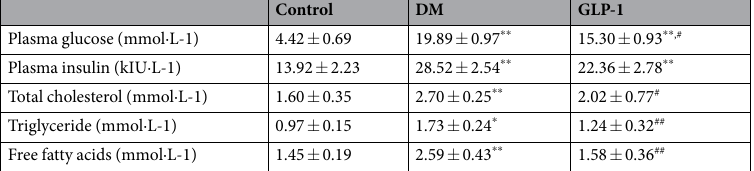
Table 1. Plasma glucose, Plasma insulin, Total cholesterol, triglyceride, and Free fatty acids. Data are shown as the mean ± SEM, n = 8 independent experiments. * P < 0.05 vs control, ** P < 0.01 vs control. # P < 0.05 vs DM group, ## P < 0.01 vs DM